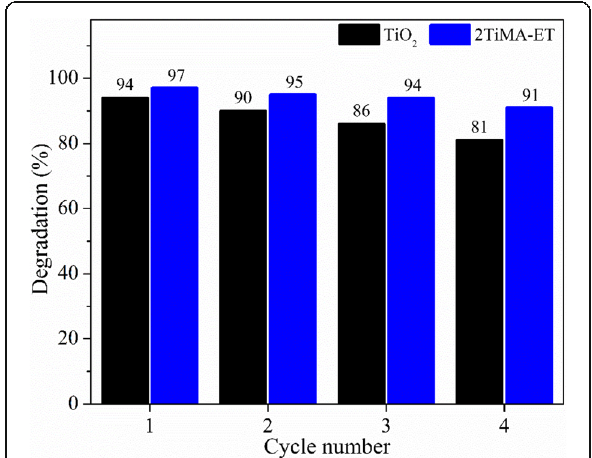
Fig. 13 Reuse tests for the TiO 2 and 2TiMA-ET photocatalysts in the degradation of MO (4 × 10 -5 M, pH =